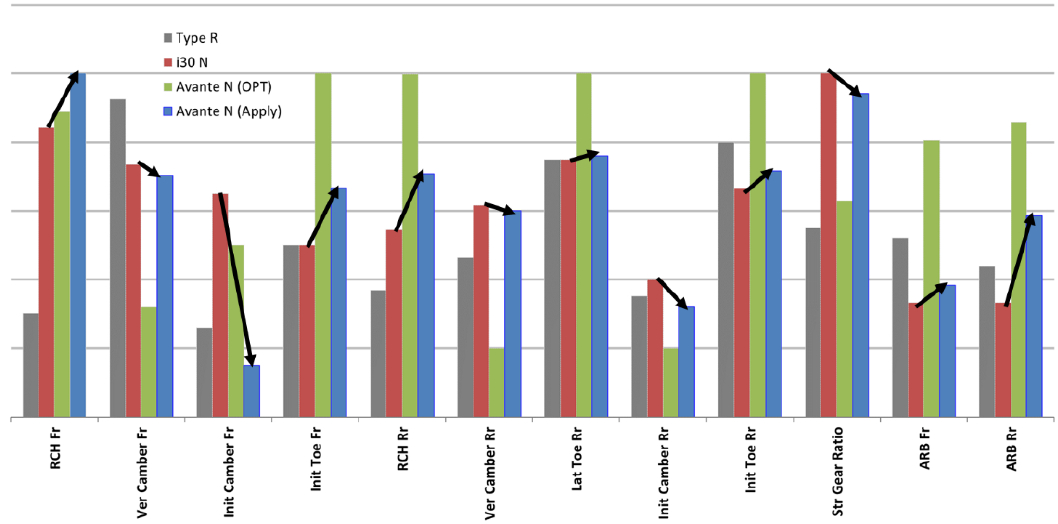
Figure 14. Performance impact factor recommendation and application results.